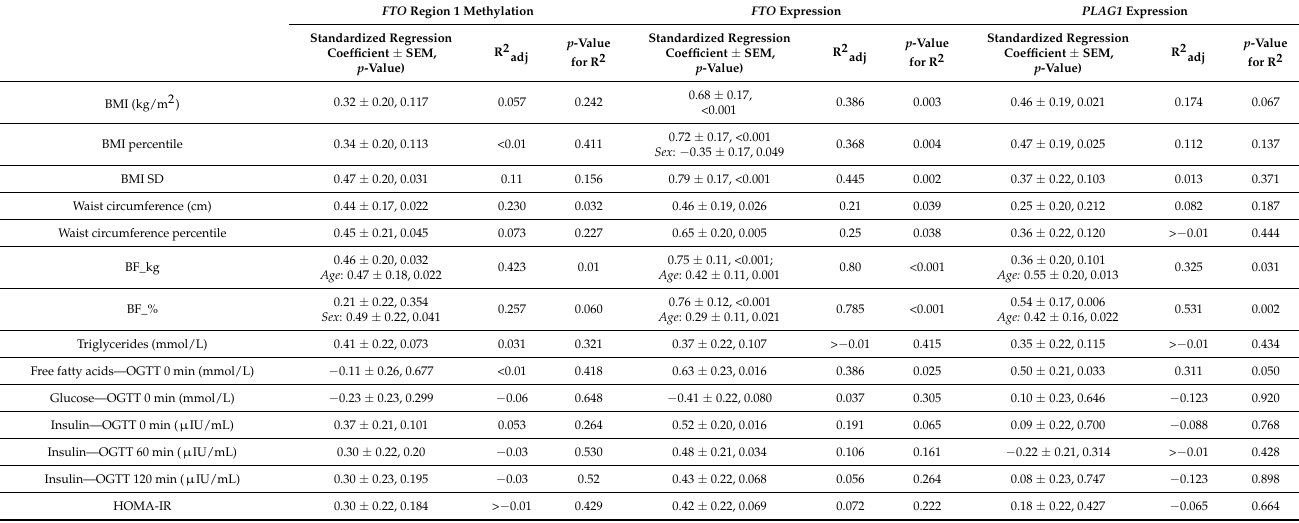
Table 7. Multiple regression adjusting genes expression and FTO region 1 methylation for age and sex of children. If age or sex significantly explained the given model, then standardized regression coefficient and p -value for them are shown